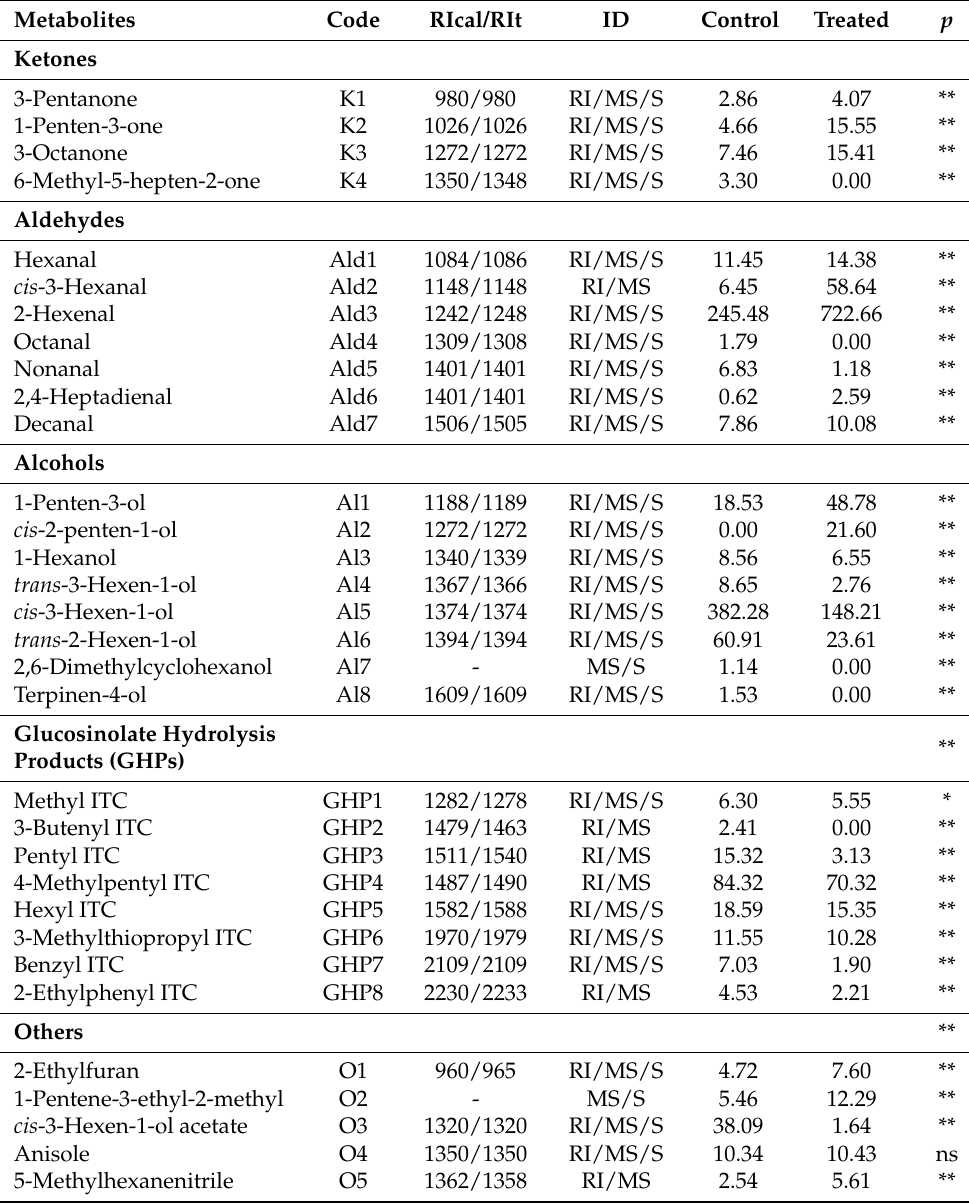
Table 3. Volatile compounds detected by HS-SPME/GC–MS in the rocket leaves treated with Bortan (Treated) and in the untreated samples (Control) and their identification